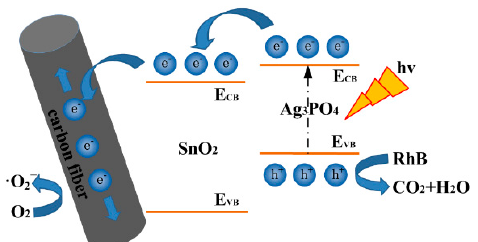
Figure 10. The schematic illustration of the photocatalytic mechanism of Ag 3 PO 4 /SnO 2 /CC.